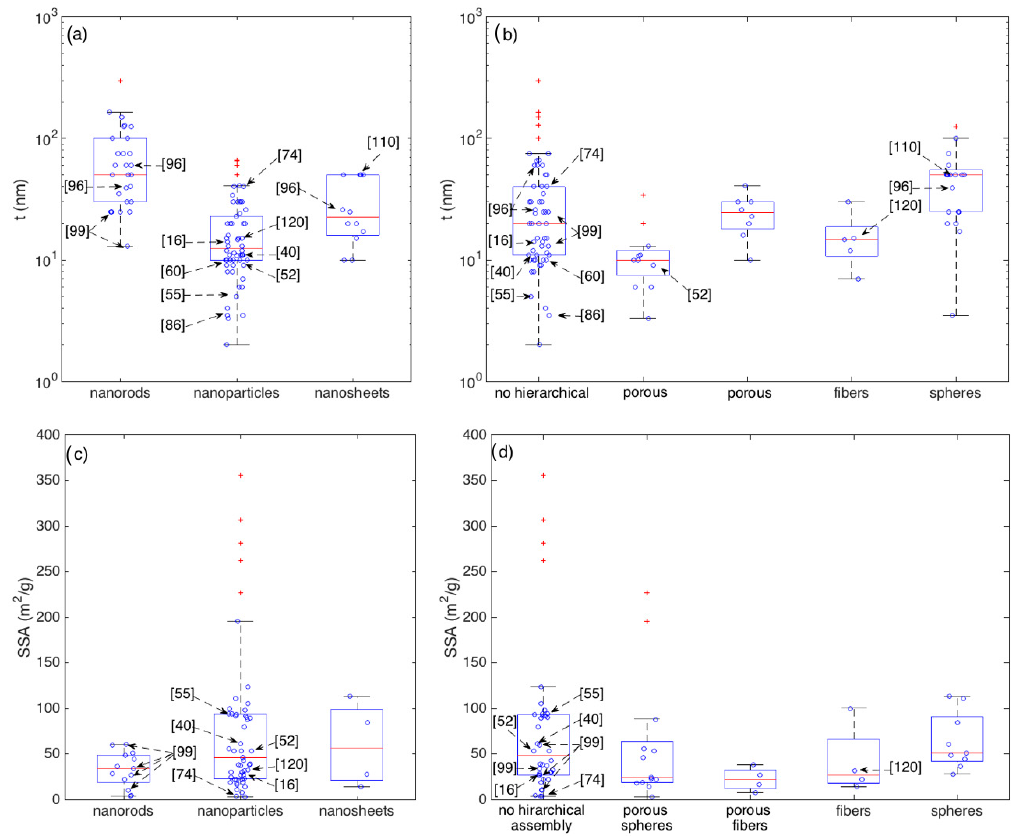
Figure 8. Boxplots showing the statistics of the crystallite thickness (t) grouped according to crystallite morphologies ( a ) and their eventual hierarchical assembly ( b ) and the statistics of the Specific Surface Area (SSA) grouped according to crystallite morphologies ( c ) and their eventual hierarchical assembly ( d ).